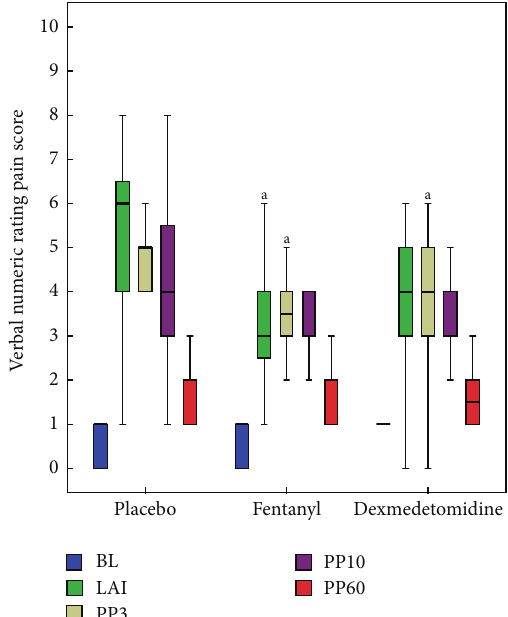
Figure 2: Box plots of perceived pain score during the study period showing median and interquartile range (25–75). BL, before starting studydruginfusion;LAI,afterinitialLAinjection;PP3,immediately after the CVCI, the patient was asked to report the peak pain